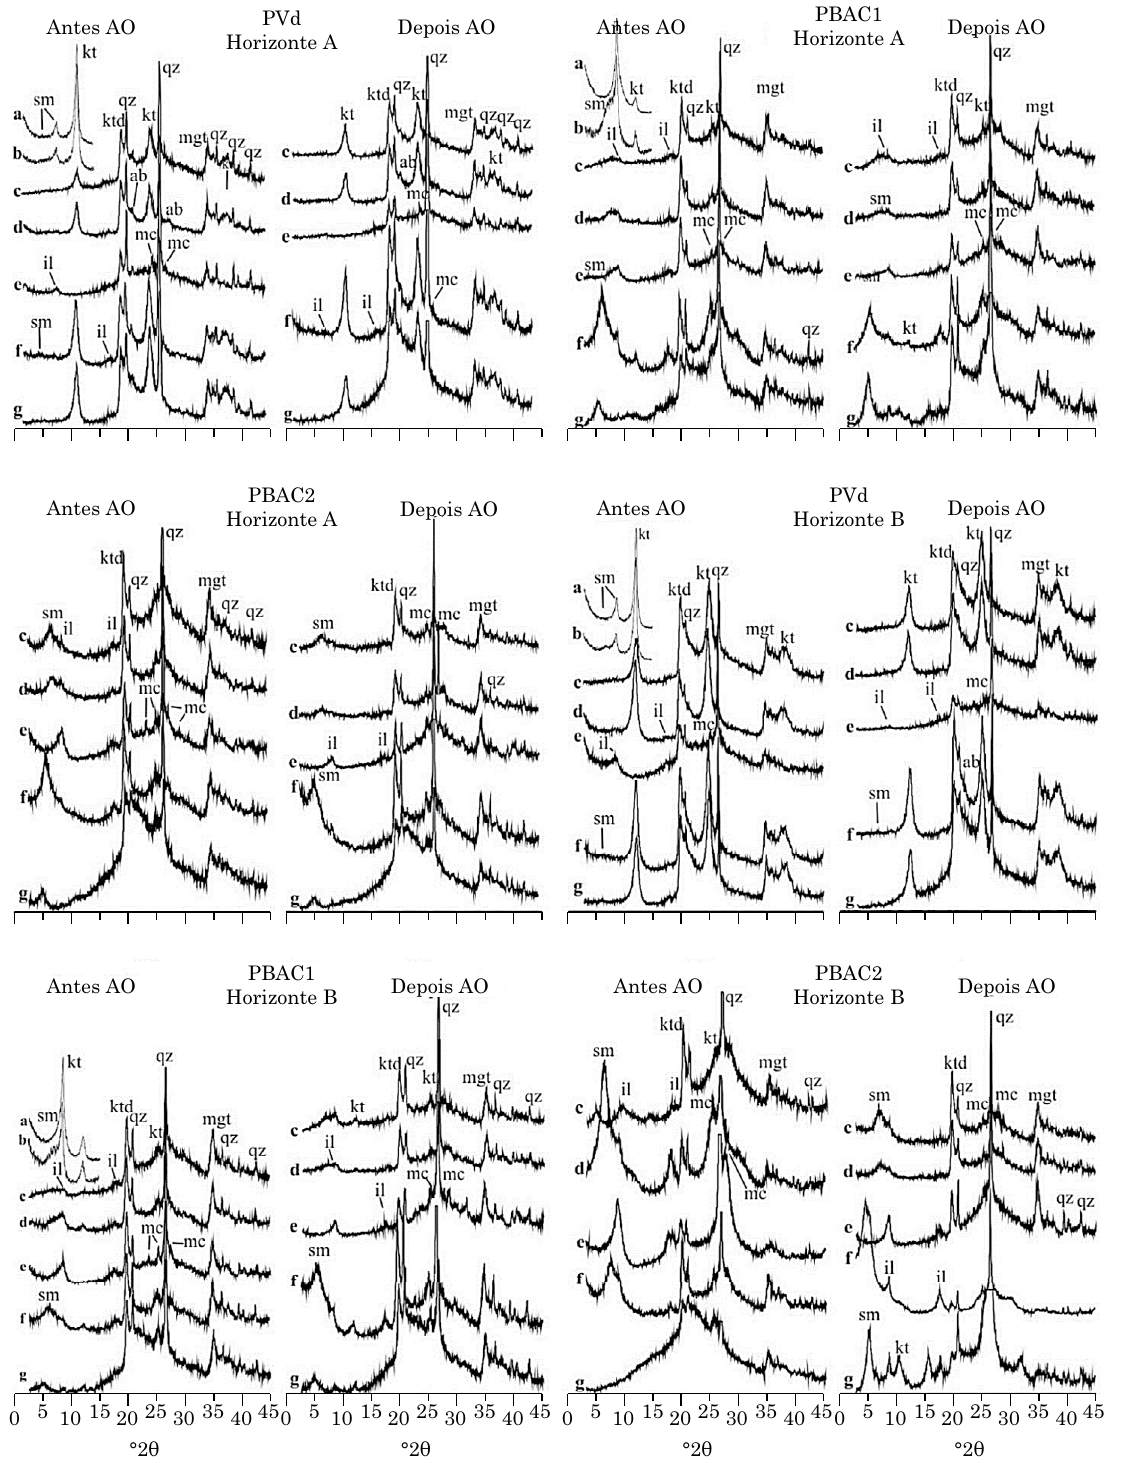
Figura 1. Difratogramas de raios-X da fração argila desferrificada dos horizontes A e Bt do Argissolo Vermelho distrófico típico (PVd), PBAC1: Argissolo Bruno-Acinzentado alítico típico – siltito (PBAC1), e Argissolo Bruno-Acinzentado alítico típico – arenito (PBAC2), antes e após a extração de K + por 2.889 h com ácido oxálico (ao). be - beidelita; no - nontronita; sm - esmectita; kt - caulinita; il - ilita; qz - quartzo; mc - microclínio; ab - albita. a - amostra saturada com li e aquecida a 250 °c; b - amostra saturada com li e glicerol e aquecida a 110 °c; c - amostra saturada com K a 25 °c; d - amostra saturada com K e aquecida a 110 °c; e - amostra saturada com K e aquecida a 550 °c; f - amostra saturada com Mg a 25 °c; e g - amostra saturada com Mg e glicerol a 25